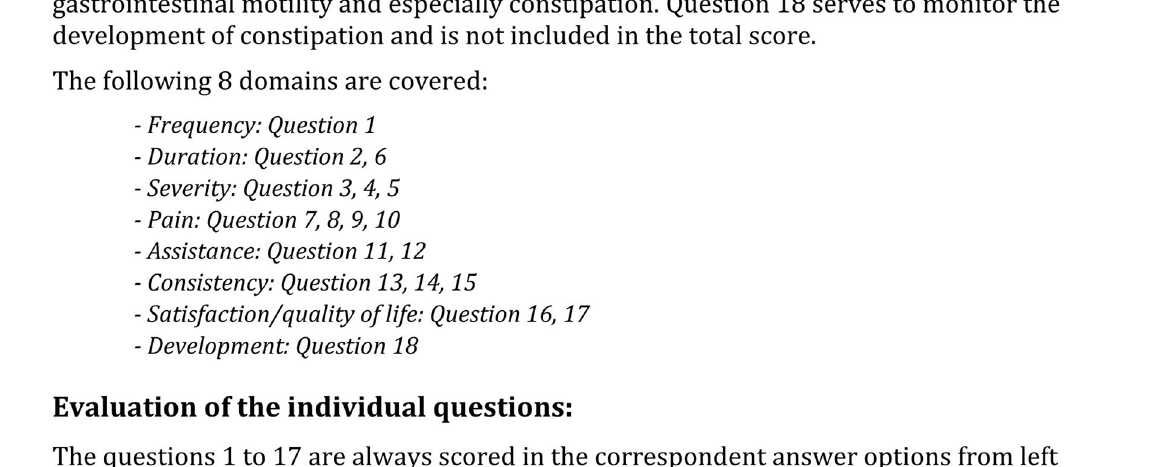
indicator for the neurologists in addition to the total score. By equalization of the design of questions as well as answer options to a 4-point multiple-choice response, ranging from no